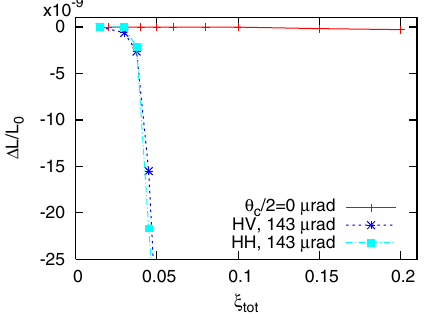
FIG. 3. Luminosity decrement as a function of total tune shift for collision with or without a crossing angle of 286 μ rad, where the tune shift ( ξ ) is 75% of Eq. (1). Blue, cyan and red points tot refer to horizontal/vertical and horizontal/horizontal crossings or to no crossing angle,